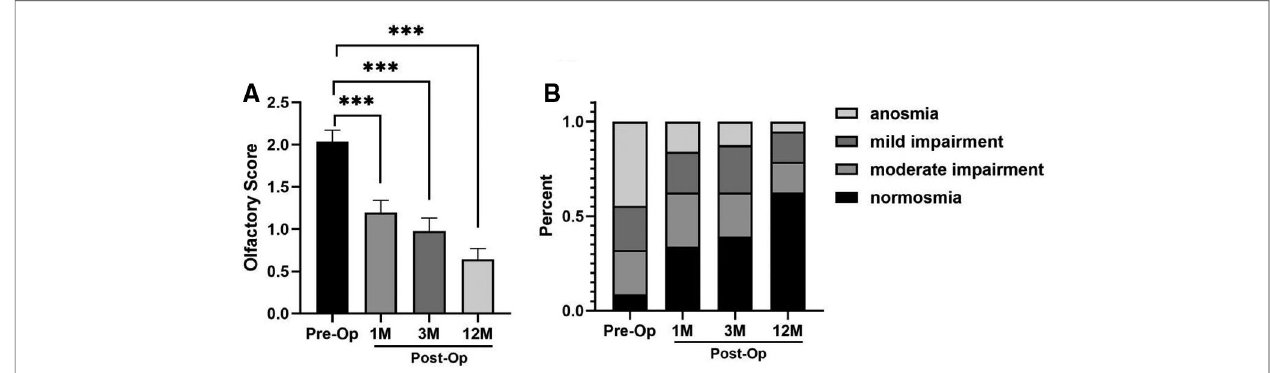
FIGURE 1 | Self-reported olfactory dysfunction score, mean±SEM ( A ). Distribution variation of the different categories of olfaction preoperatively and 1 month, 3 months, and 12 months after ESS in patients with CRSwNP ( B ) ( n =56, *** P